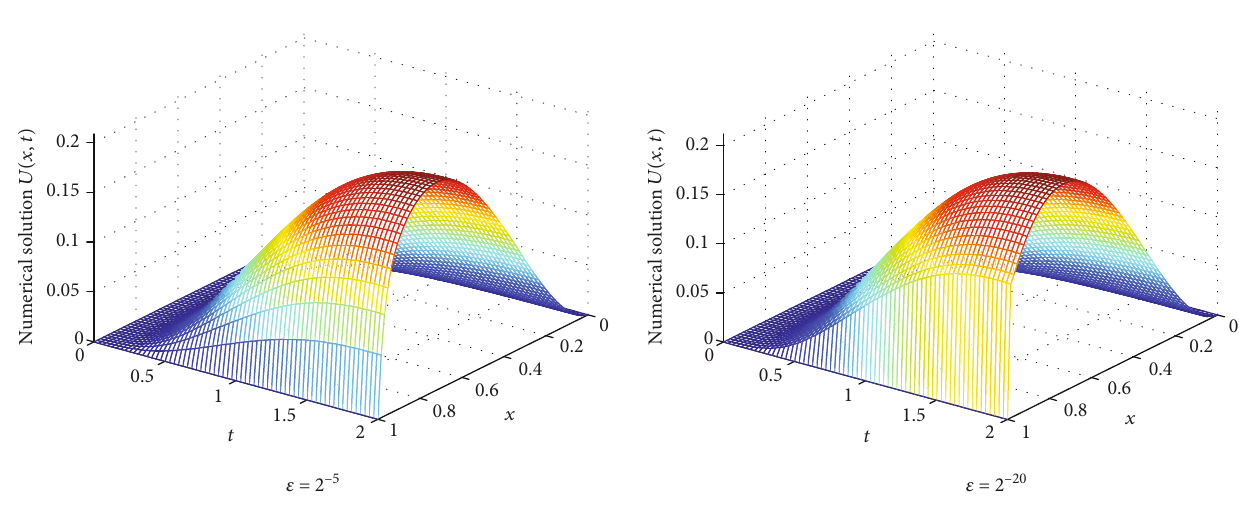
Figure 2: Solution of Example 20, with boundary layer